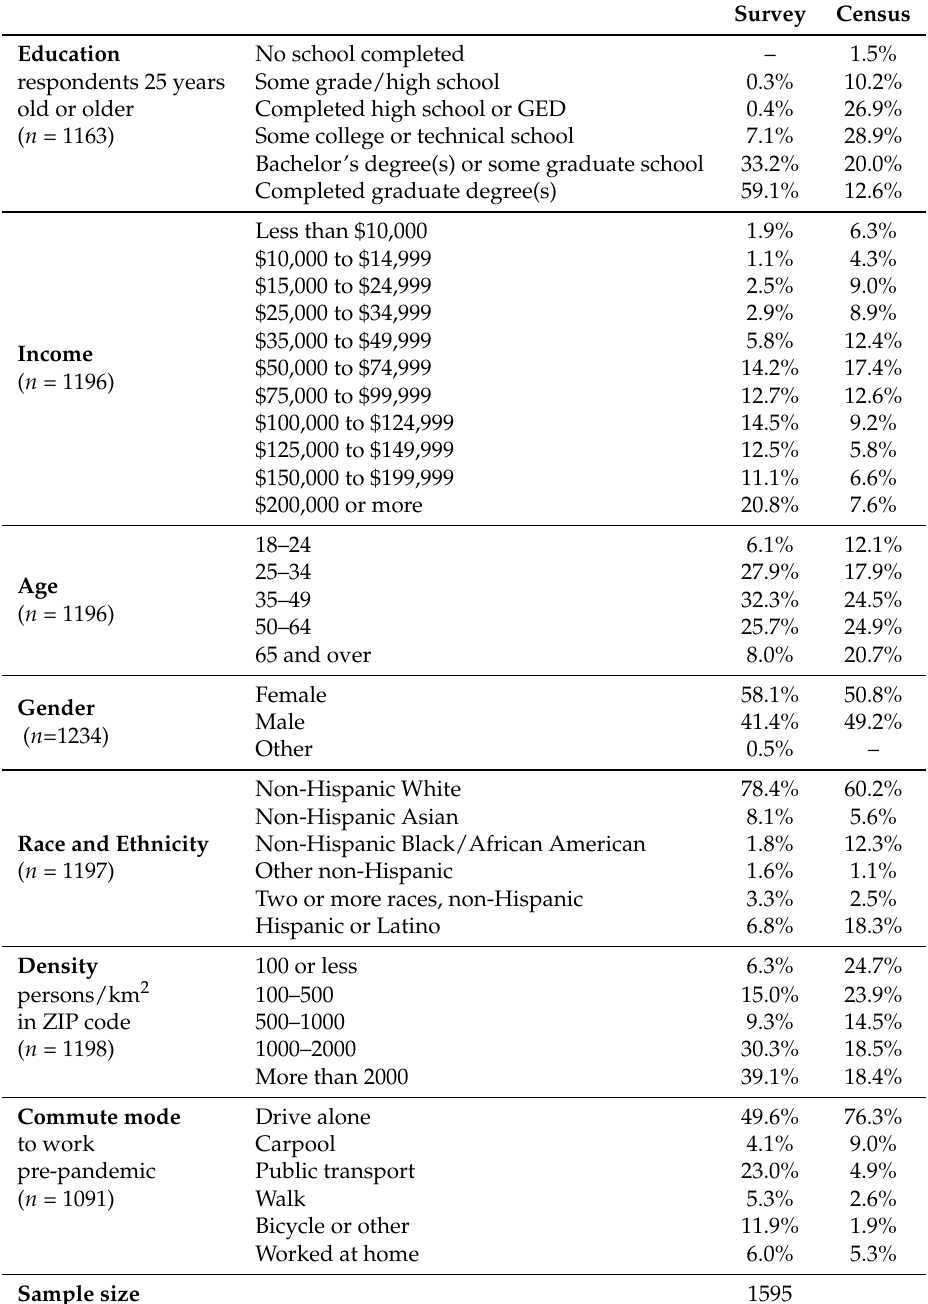
Table 1. Demographics of survey respondents, relative to census totals (from 2018 1-year American Community Survey, density from 2014–2018 5-year American Community